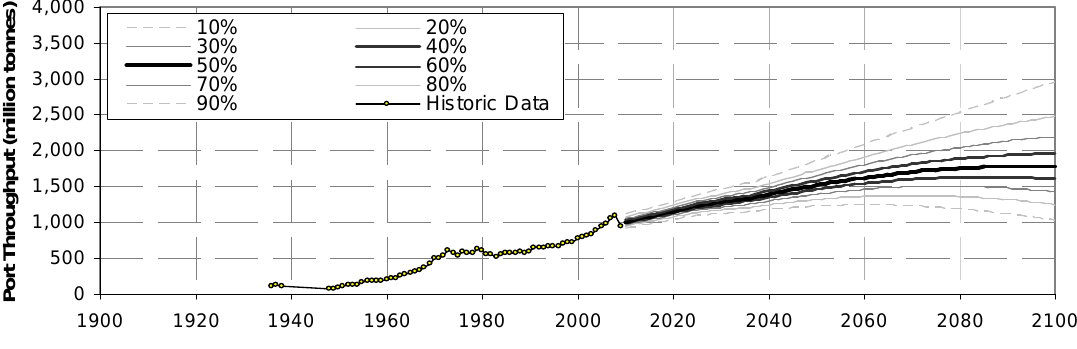
Figure 14. Naïve Forecast based on Levels Approach of Equation 1